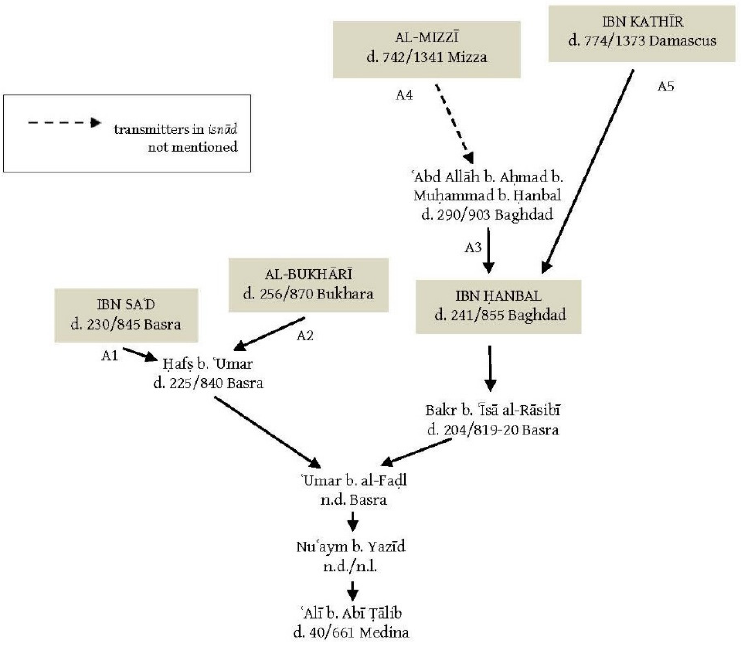
Figure 5. The isn¯ad bundle Figure 5. The isn ā d bundle of ʿ Umar b. al-Fa ḍ l’s traditions from ʿ Al ī b. Ab ī Ṭ ā lib.